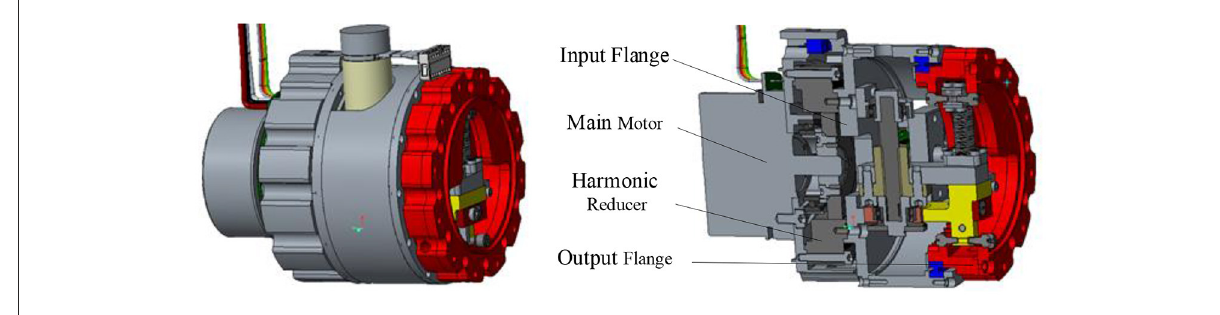
FIGURE1 Variable stiffness joint model.